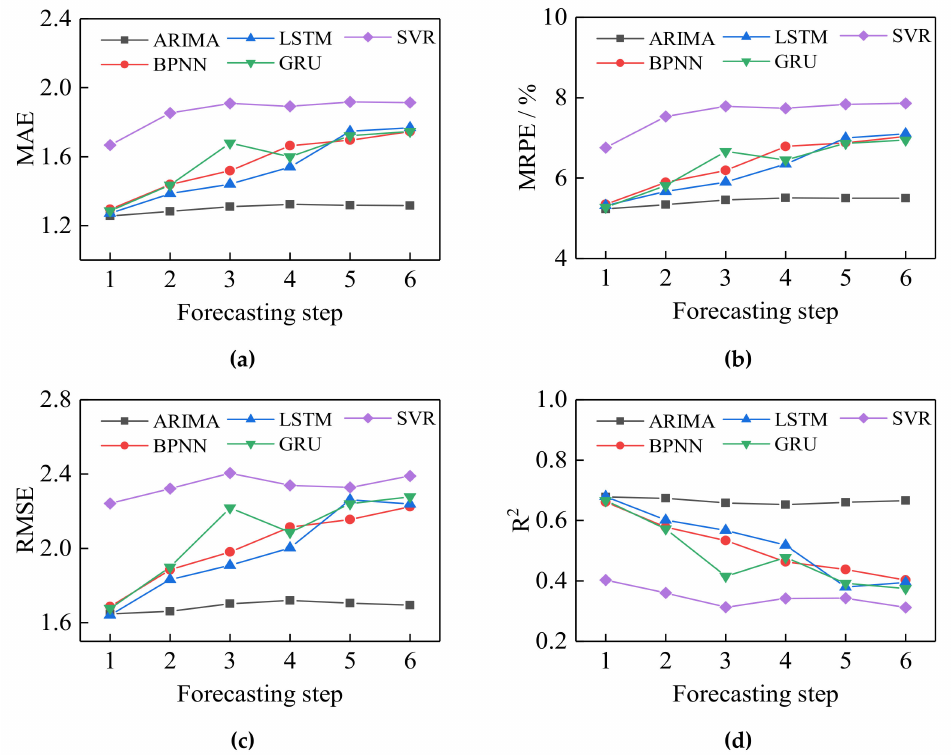
Figure 11. Multi-step forecasting errors of different models for the 1 min maximum wind speed. ( a ) MSE; ( b ) MRPE; ( c ) RMSE; ( d ) R 2 .